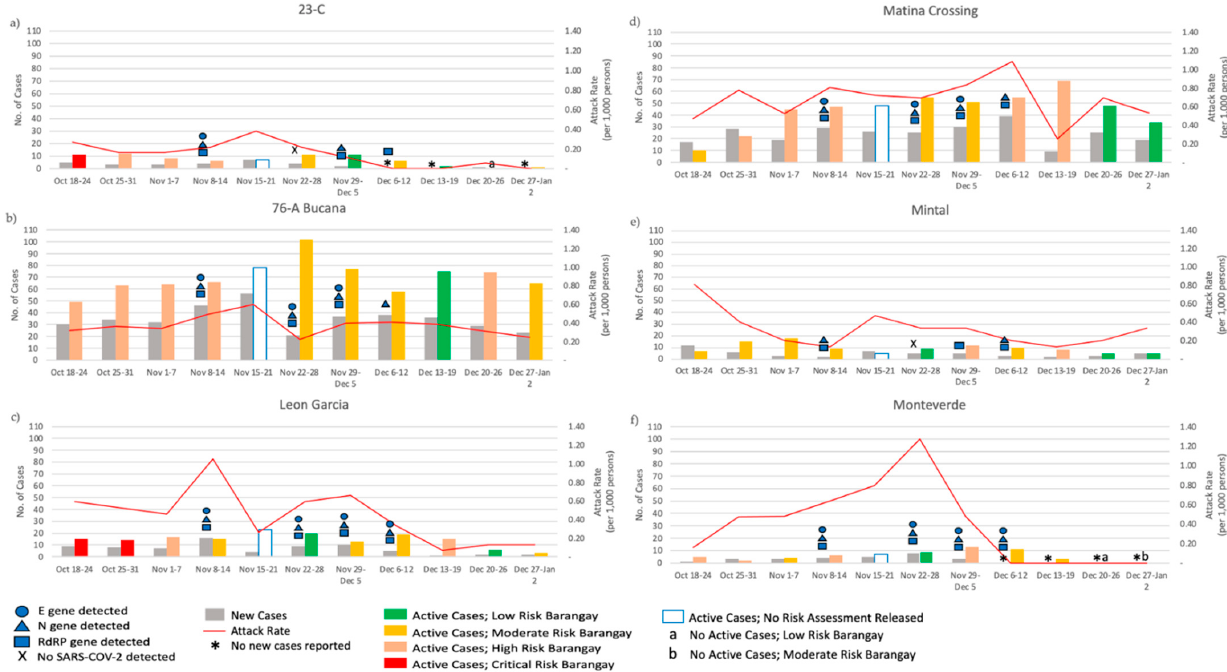
Figure 4. Detection of SARS-CoV-2 in wastewater and COVID-19 clinical surveillance status and in six communities of Davao City, Philippines from 18 October 2020 to 2 January 2021. SARS-CoV-2 RNA was detected in community wastewater from ( a ) 23-C, ( b ) 76-A Bucana, ( c ) Leon Garcia, ( d ) Matina Crossing, ( e ) Mintal, and ( f ) Monteverde in at least three of the four weeks of testing.